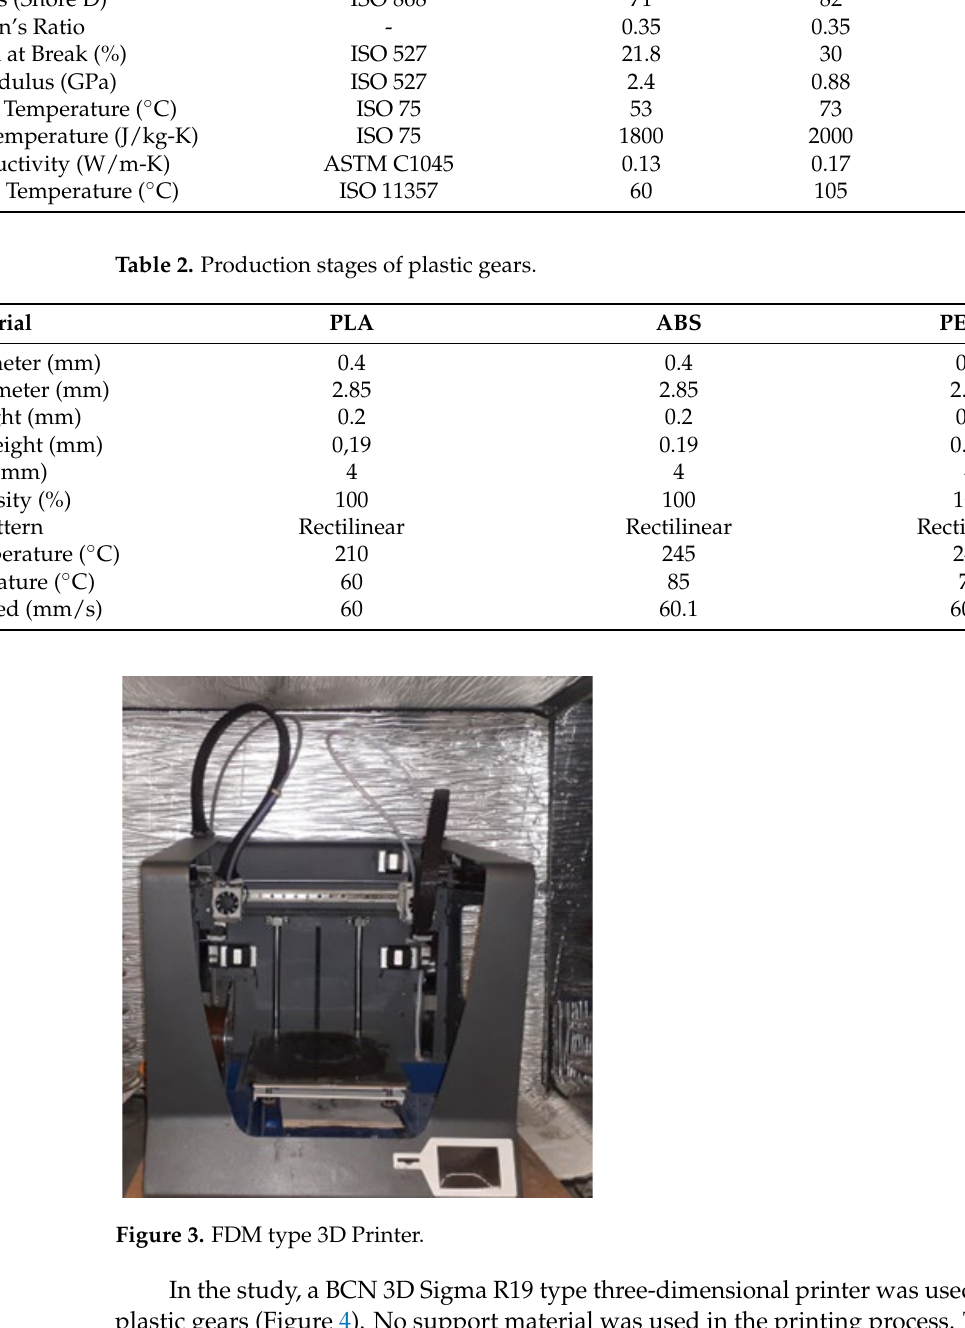
Table 2. Production stages of plastic gears.